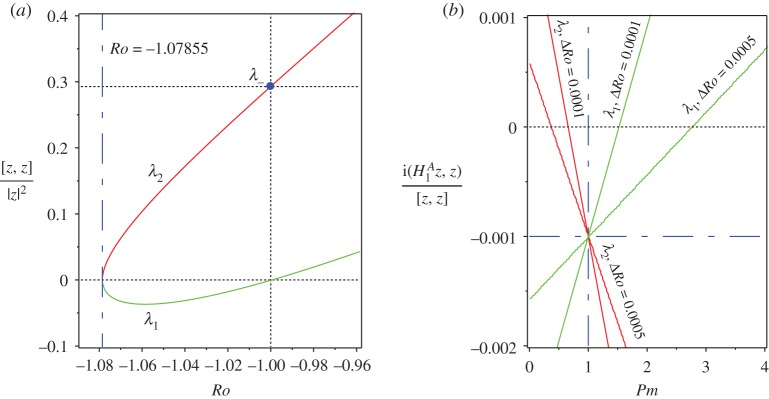
For S=1, Rb=−1, n=2 and α=1 (a) the values of the normalized indefinite inner product [z,z]/(z,z) calculated with the eigenvectors at the imaginary eigenvalues λ1 and λ2 shown in figure 2a that participate in the Hamilton–Hopf bifurcation at Ro=Roc≈−1.07855. For Roc<Ro<−1, the Krein sign of λ1 is negative and the Krein sign of λ2 is positive. (b) For Rm=1000, the values of the real increment δλA to eigenvalues λ1 with the negative Krein sign and to eigenvalues λ2 with the positive Krein sign according to equation (4.1). The interval of negative increments (stability) around Pm=1 becomes narrower as ΔRo:=Ro−Roc tends to zero. (Online version in colour.)